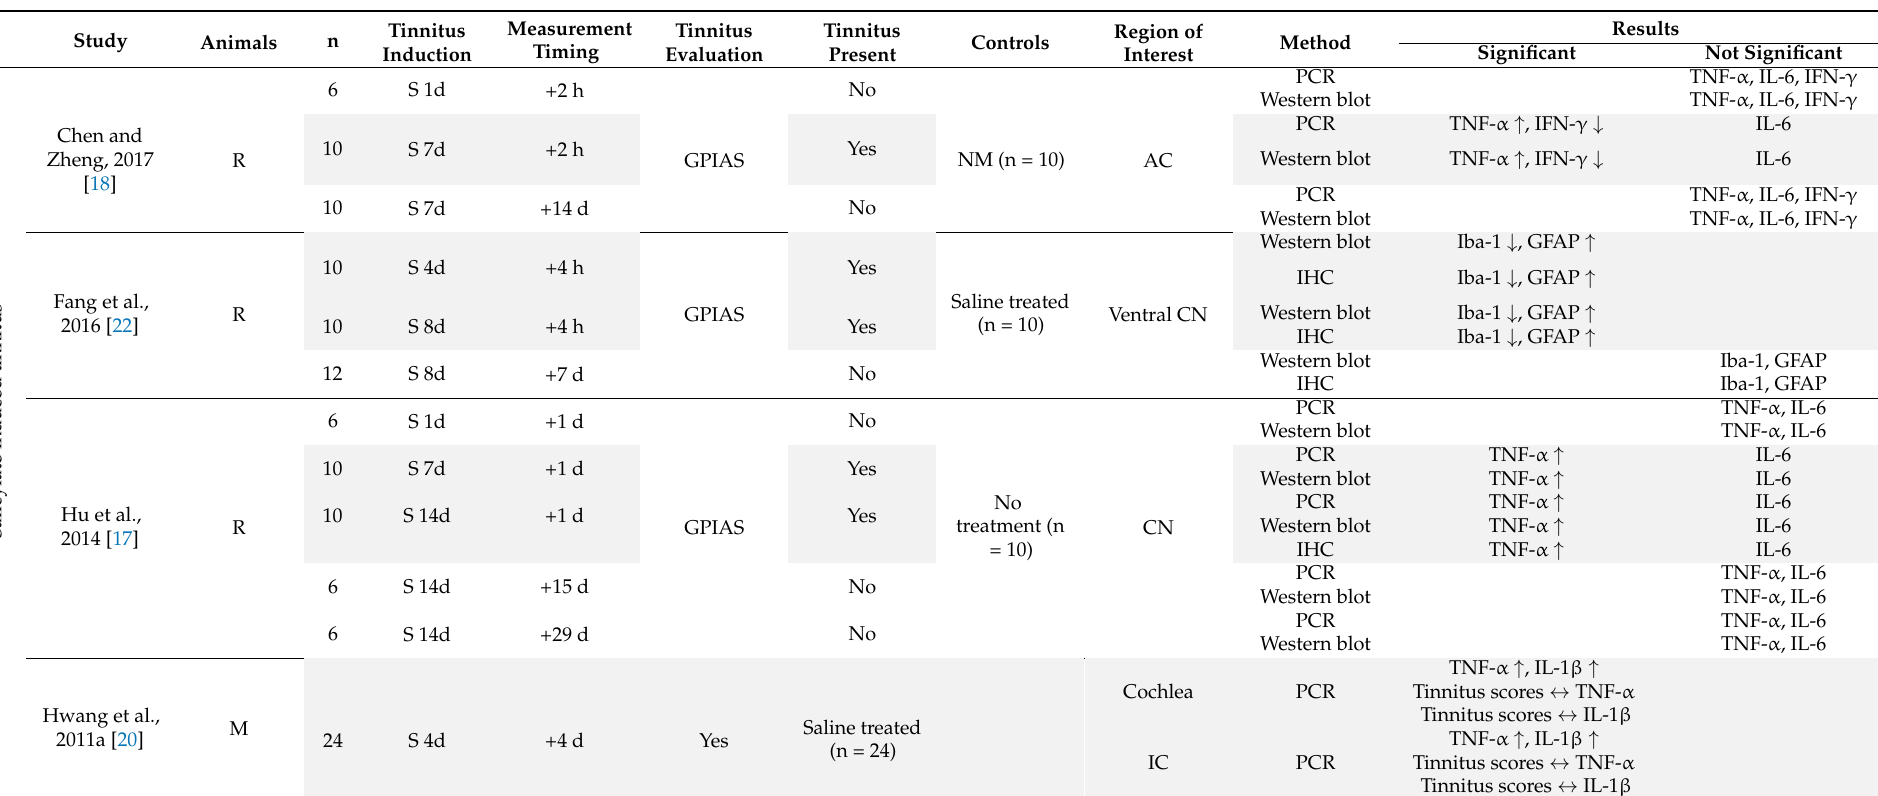
Table 1. Animal studies assessing inflammatory markers in tinnitus. Results relating to animals with behavioral signs of tinnitus are marked by a light-grey